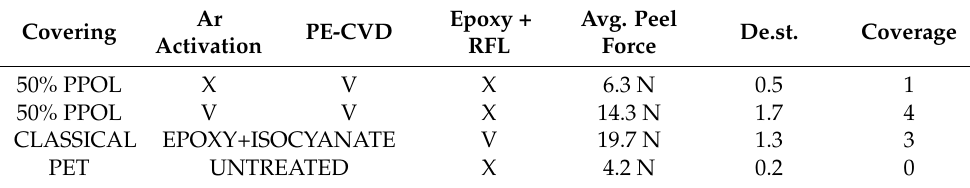
Table 6. CRA test results for the PPOLs obtained at 50% d.c. that differ for the Ar activation. The adhesion is expressed by the extraction force and the coverage. The adhesion of the PPOLs is compared with the adhesion of the RFL system and with the untreated PET. In the table, V is used when a treatment is performed, and X is used when no treatment is performed.